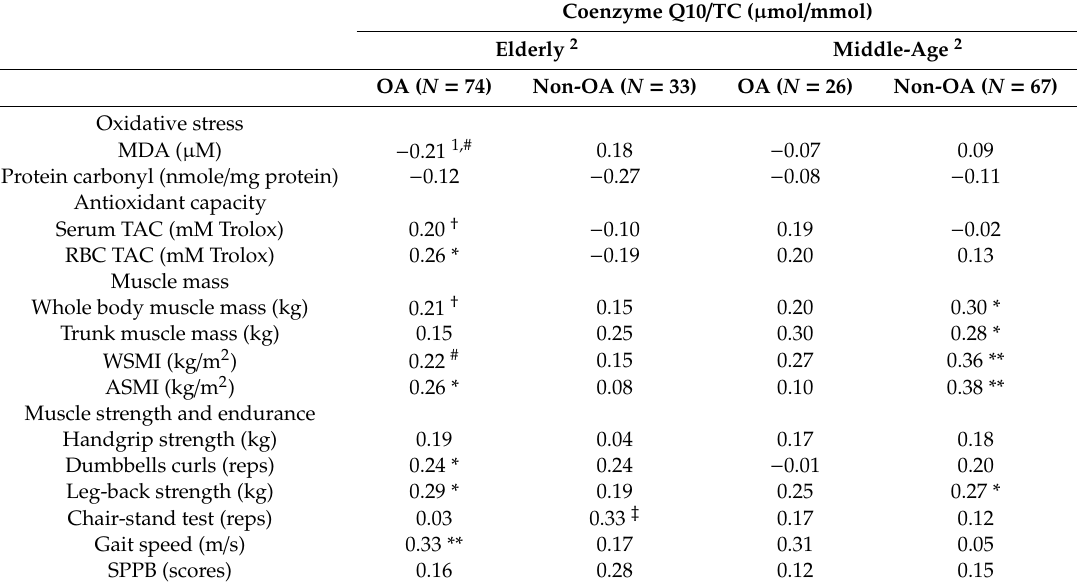
Table 3. Correlation between coenzyme Q10 status and oxidative stress, muscle mass, muscle strength, and muscle endurance stratified by age.